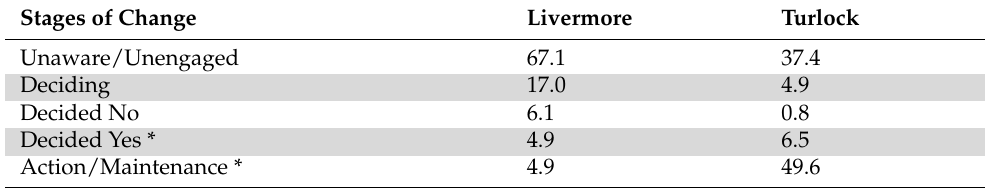
Table 5. Percent of participants in the Livermore and Turlock groups by stage of change. Stages of Change